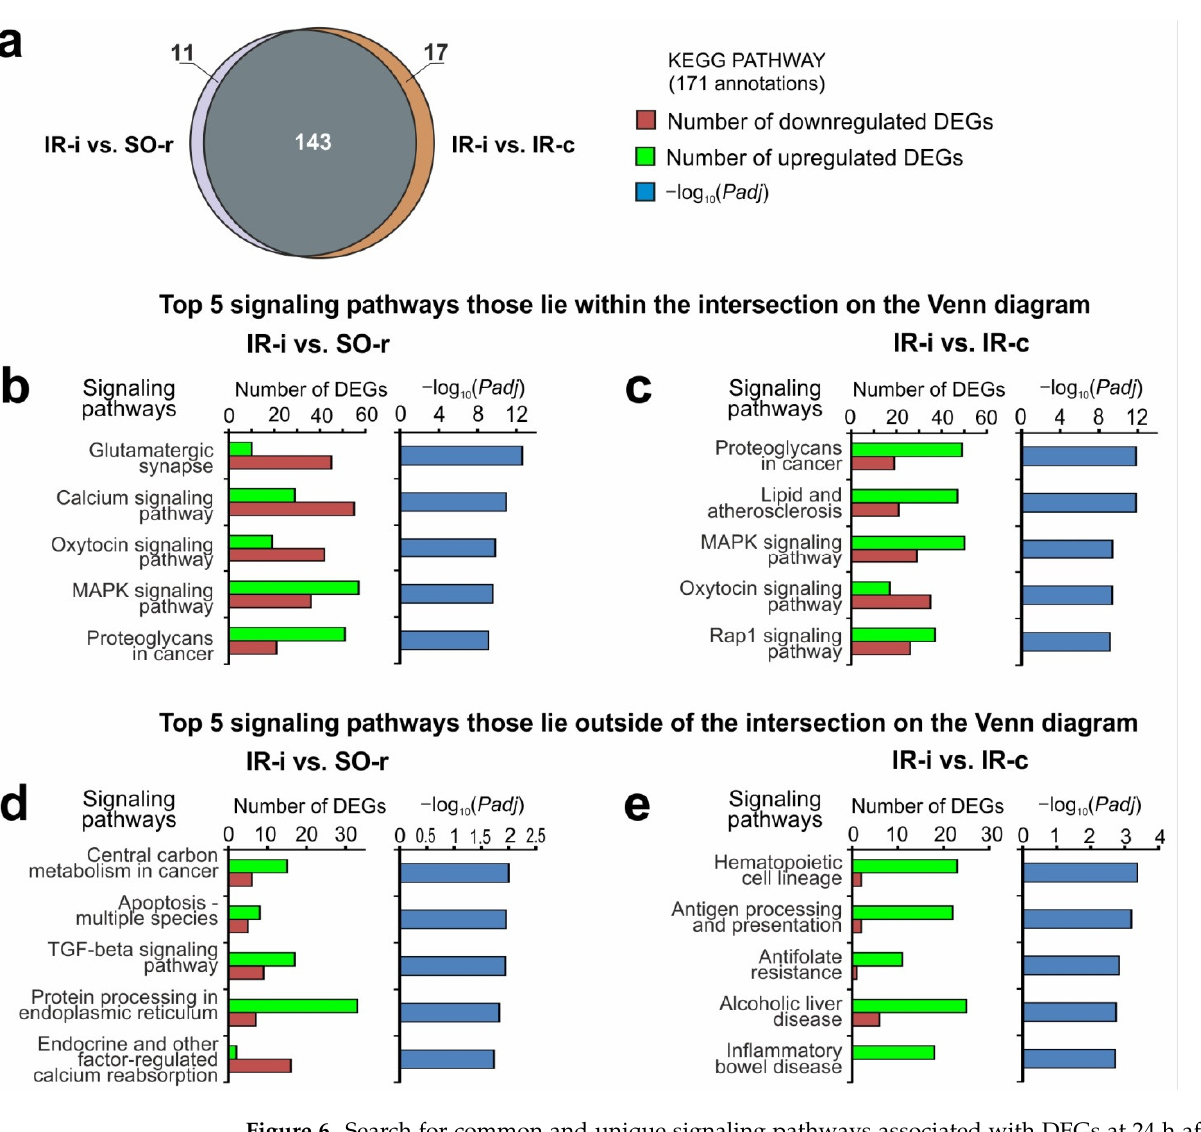
Figure 6. Search for common and unique signaling pathways associated with DEGs at 24 h after tMCAO in subcortical structures of the IH related to the sham-operated and contralateral controls. A pathway enrichment analysis of DEGs in two pairwise comparisons, i.e., IR-i vs. SO-r and IR-i vs. IR-c, was carried out according to DAVID (2021 Update). ( a ) Schematic comparison of the KEGG PATHWAY (KP) annotations associated with the DEGs obtained in two pairwise comparisons, i.e., IR-i vs. SO-r and IR-i vs. IR-c, as assessed using a Venn diagram. The numbers on the diagram segments indicate the number of annotations. ( b , c ) The most significant signaling pathways and corresponding Padj -values, as well as the number of up- and downregulated DEGs that lay within the intersection on the Venn diagram ( a ) in IR-i vs. SO-r and ( b ) in IR-i vs. IR-c ( c ). ( d , e ) The most significant signaling pathways and corresponding Padj -values, as well as the number of up- and downregulated DEGs that lay outside of the intersection on the Venn diagrams ( a ) in IR-i vs. SO-r and ( d ) in IR-i vs. IR-c ( e ). DEGs and signaling pathways with Padj < 0.05 were exclusively selected for the analysis. Three animals were included in each comparison